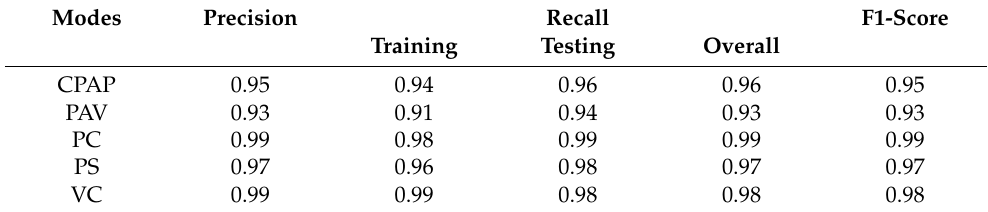
Table 12. Model evaluation report for Decision-Tree algorithm.